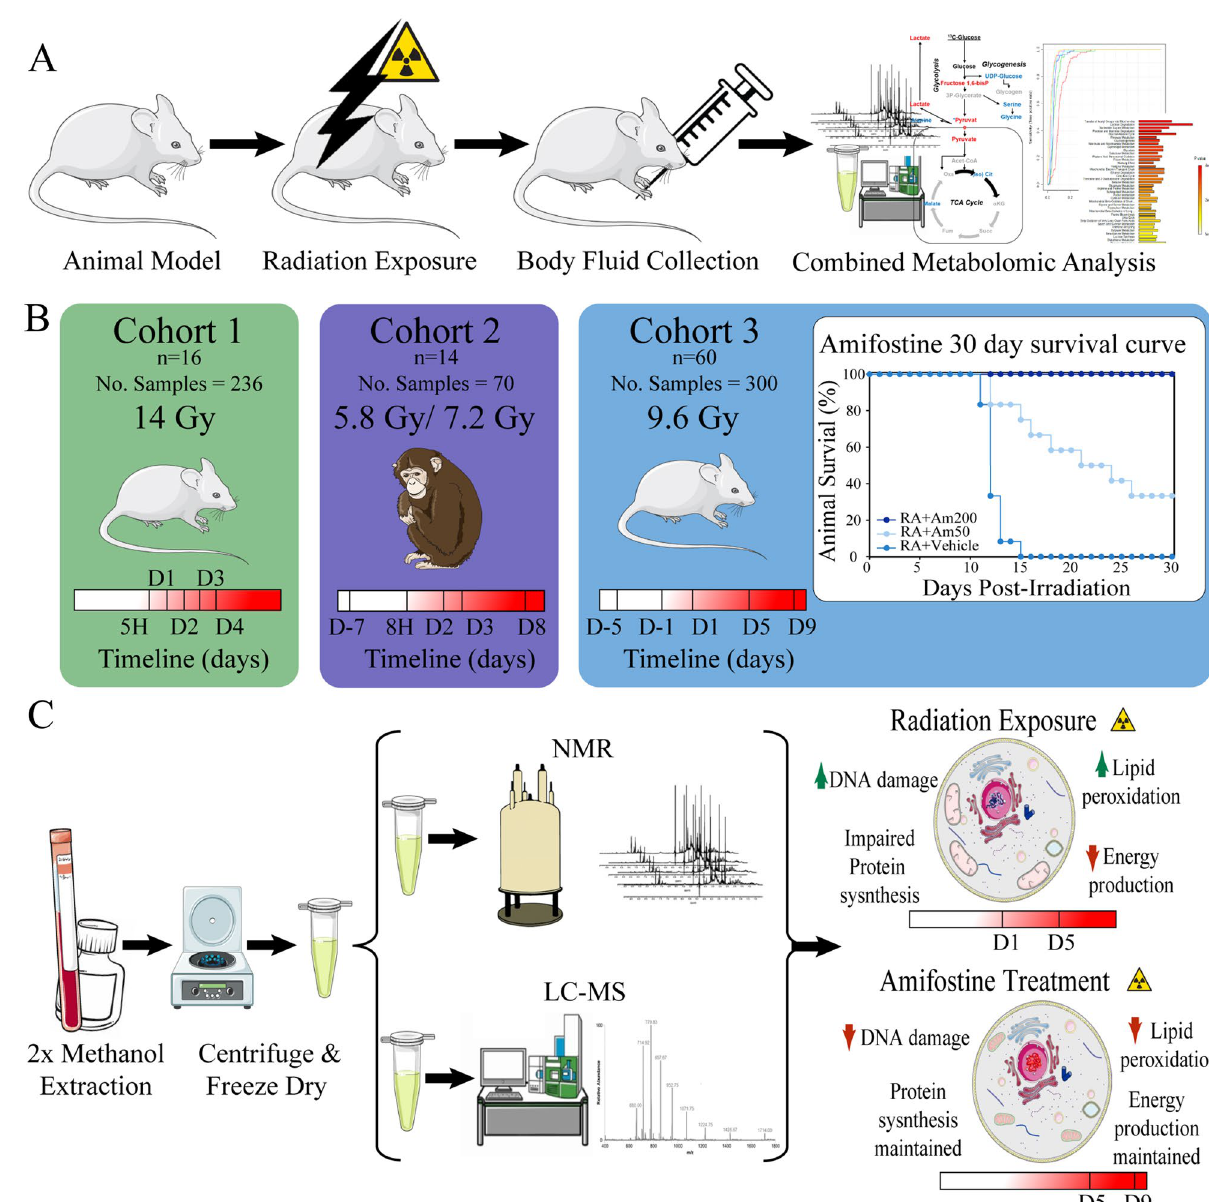
Figure 1. Combined metabolomics experimental design. ( A ) Study goals were to identify radiation biomarkers and monitor amifostine radioprotection. ( B ) Cohort variables included animal number(n), sample number (No. samples), radiation exposure, species, and biofluid collection time points. ( C ) A schematic of the combined NMR and LC–MS metabolomics approach. This figure was generated using medical images from